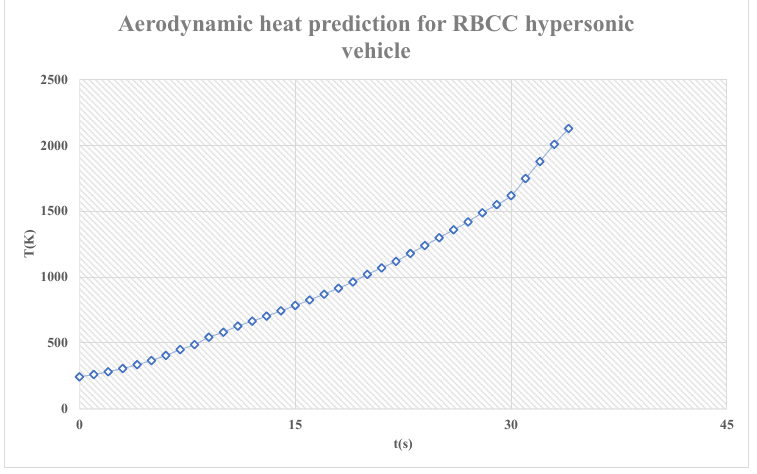
Figure 27. The aerodynamic heat prediction for RBCC scramjet-propelled vehicle in the flight path.